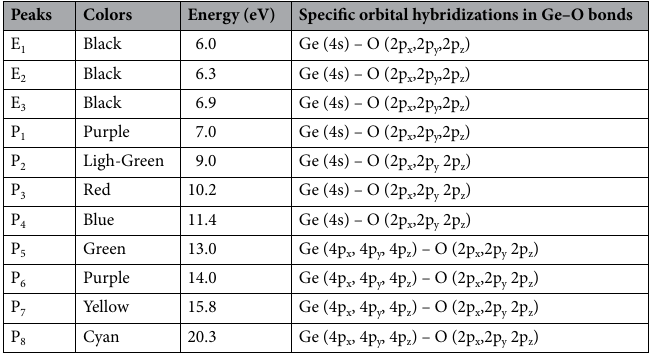
Table 1. Calculated the prominent absorption structures and the leading transition of each peaks. E i denotes i th excition, while P i denotes i th interband transition peaks.